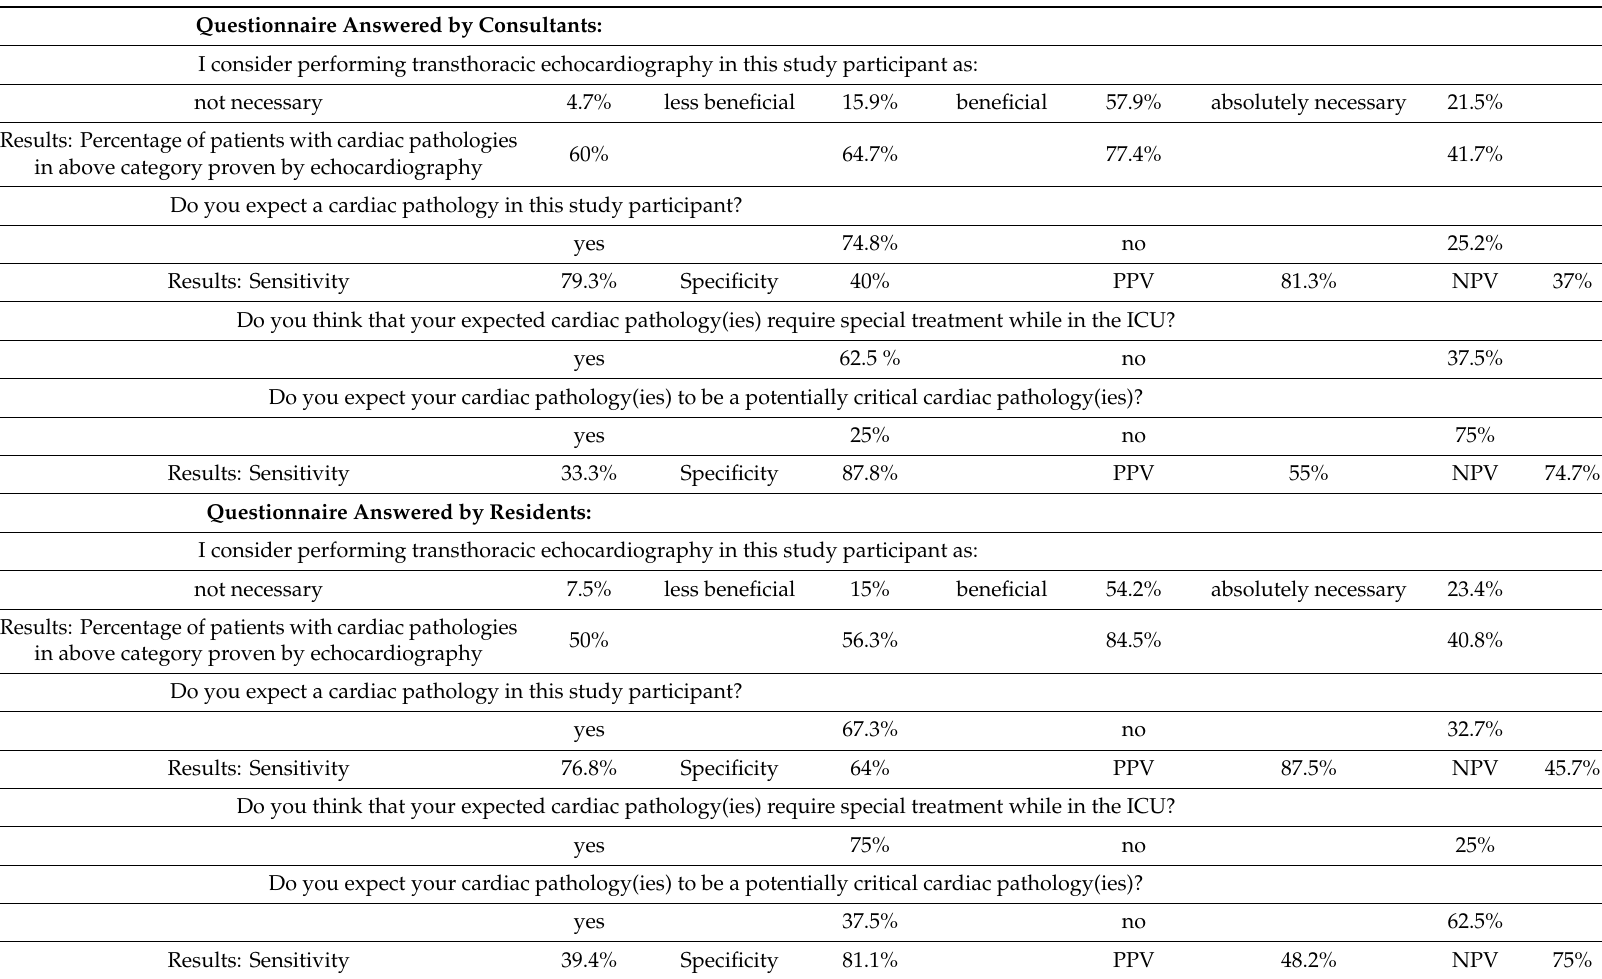
Table 1. Questionnaire for consultants and residents regarding expected cardiac